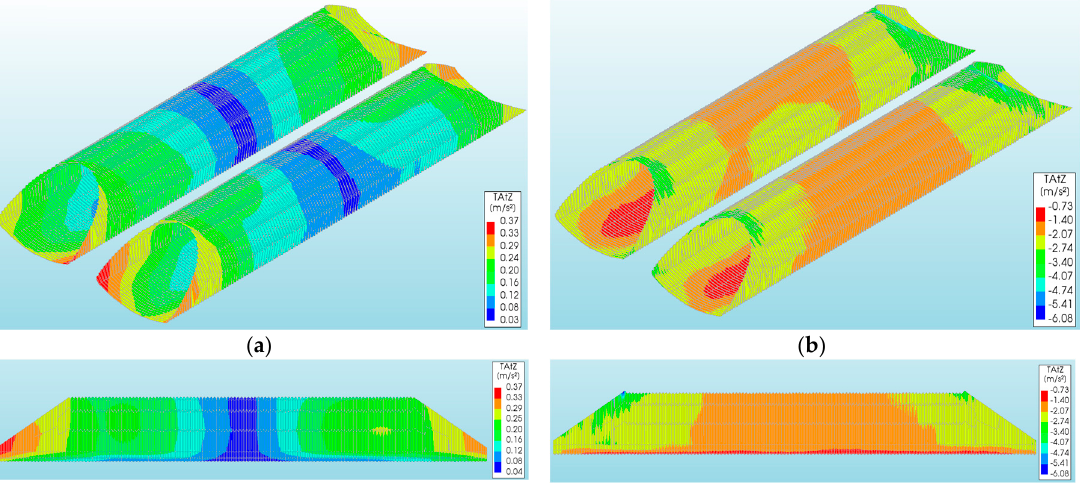
Figure 11. Maximal values of acceleration of the CSP shell: ( a ) Rockburst for model Ia, ( b ) El Centro for model Ib.